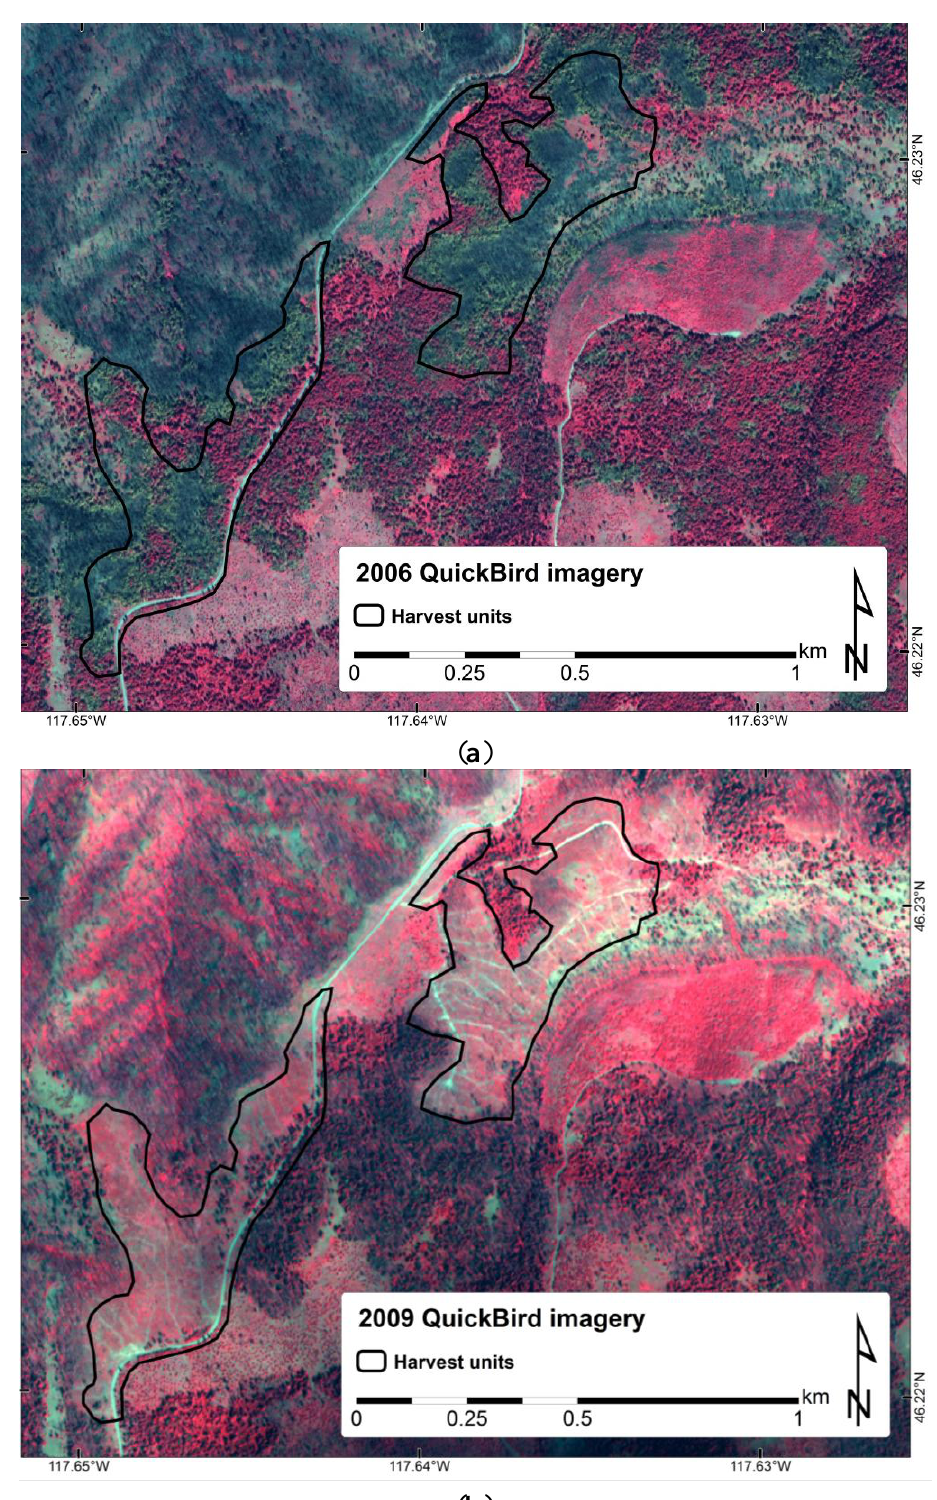
Figure 2. ( a ) Pre- and ( b ) post-salvage QuickBird image from the School Fire showing the change in soil exposure. Harvest units are delineated by a black line. Salvage skid trails are visible in (b) where trees existed in the 2009 image (white linear